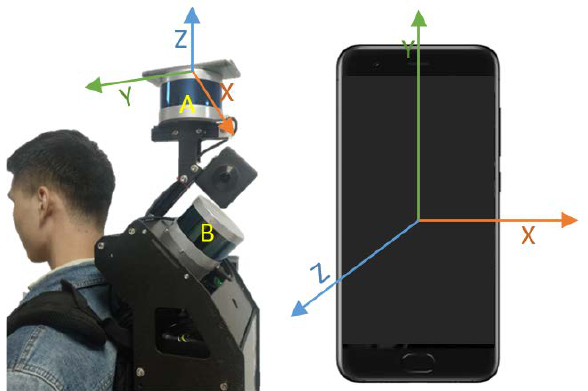
Figure 5. The smart phone’s position and